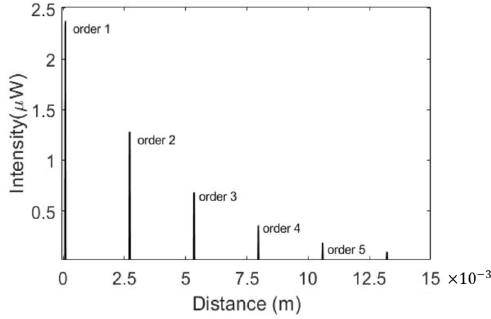
Figure 4. Ring-down waveforms of MRR.